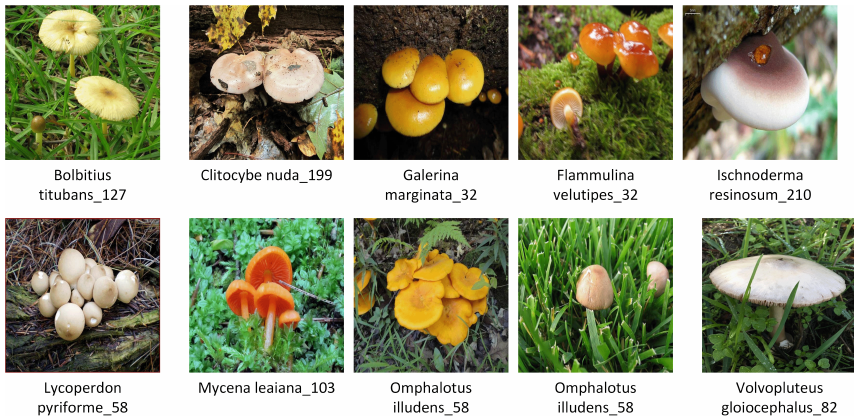
Figure 2. Images of some species of mushrooms included in MO106 .